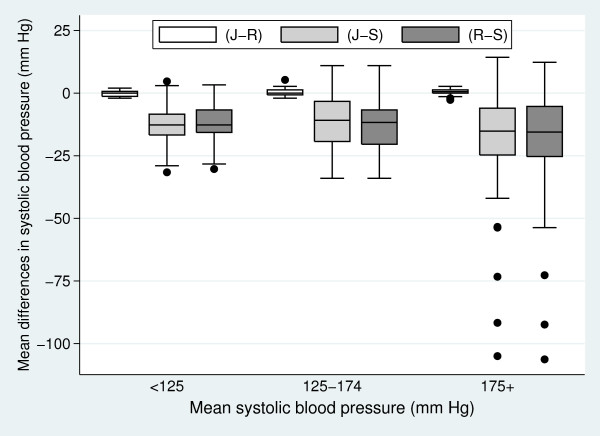
Box-plot of subject's mean difference between systolic blood pressure
measurements (mm Hg) by their mean systolic blood pressure measurements
grouped into three categories (< 125 mm Hg, 125–174 mm Hg, and 175+
mm Hg) for pair-wise comparisons (J and R), (J and S), and (R and
S).